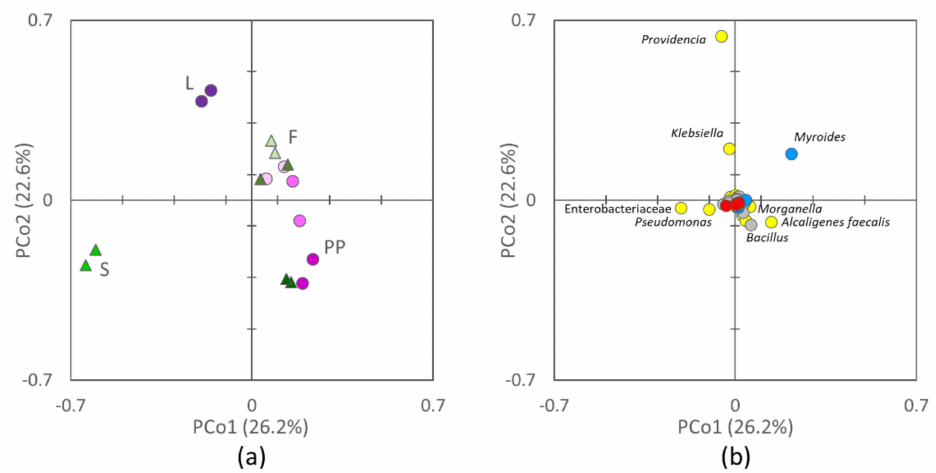
Figure 1. Two-dimensional (2d) Principal Coordinate Analysis (PCoA) visualization of microbiota beta diversity (Bray–Curtis) among initial larvae (L), S, PP, and frass (F): ( a ) scores of L (green circle), S (green triangles), PP (pink circles, with 20, 27, and 33 ◦ C from the lightest to the darkest), and F (pink triangles, with 20, 27, and 33 ◦ C from the lightest to the darkest), ( b ) contribution of the single bacterial taxa (Proteobacteria, yellow; Bacteroidetes, blue, Firmicutes, gray; Actinobacteria, red). Labels indicate taxa with the greatest contribution along PCo1 and